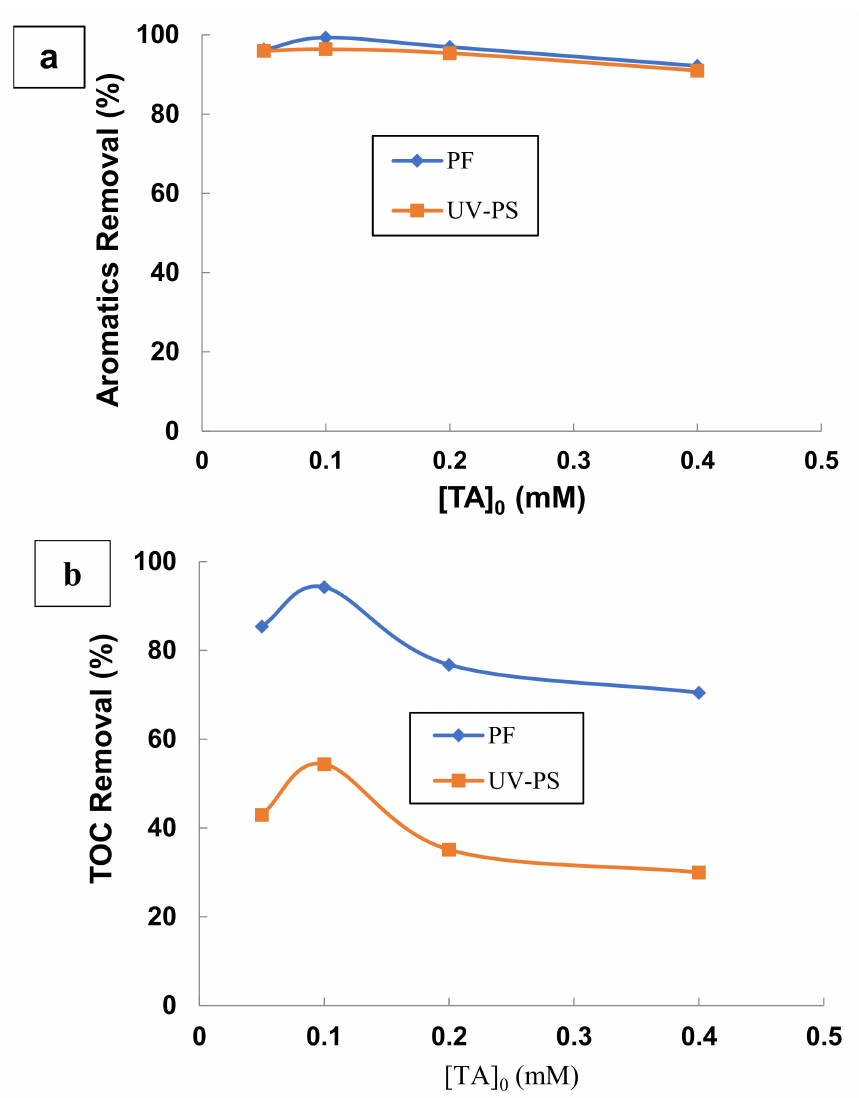
Figure 8. Effect of TA initial concentration on ( a ) aromatics removal and ( b ) TOC removal by UV/persulfate (UV-PS) and photo-Fenton (UV/H 2 O 2 /Fe 2+ ) processes under optimal conditions. (UV/PS: [TA] = 0.05–0.4 mM, [K 2 S 2 O 8 ]/[TA] = 531, pH = 9 and T = 25 ◦ C; UV/H 2 O 2 /Fe 2+ : [TA] = 86–680 mg L − 1 , [H 2 O 2 ]/[Fe 2+ ] = 164, [H 2 O 2 ]/[TA] = 294, pH = 3, and T = 25 ◦